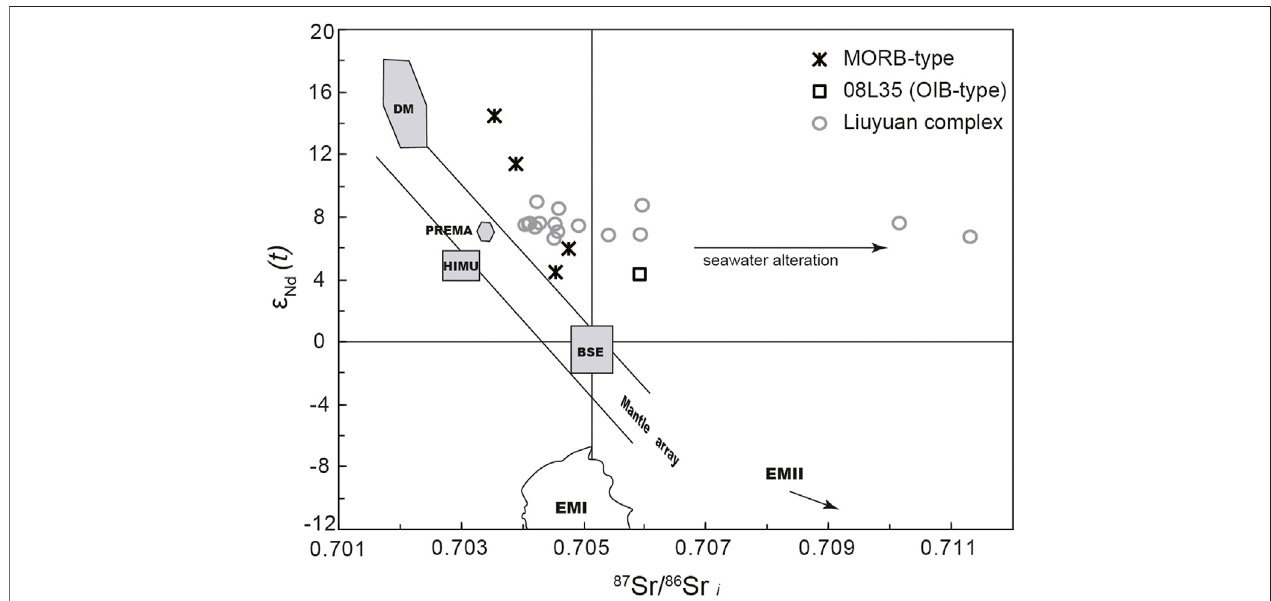
FIGURE 10 | ε Nd (t) vs. initial ( 87 Sr/ 86 Sr) i (Ma) diagram for the Huaniushan complex in Beishan orogen. DM, Depleted mantle; BSE, Bulk silicate earth; EMI and EMII, enriched mantle; HIMU, mantle with high U/Pb ratio; PREMA (Zindler and Hart, 1986). The Sr-Nd isotope data of the Liuyuan complex are after (Mao et al.,